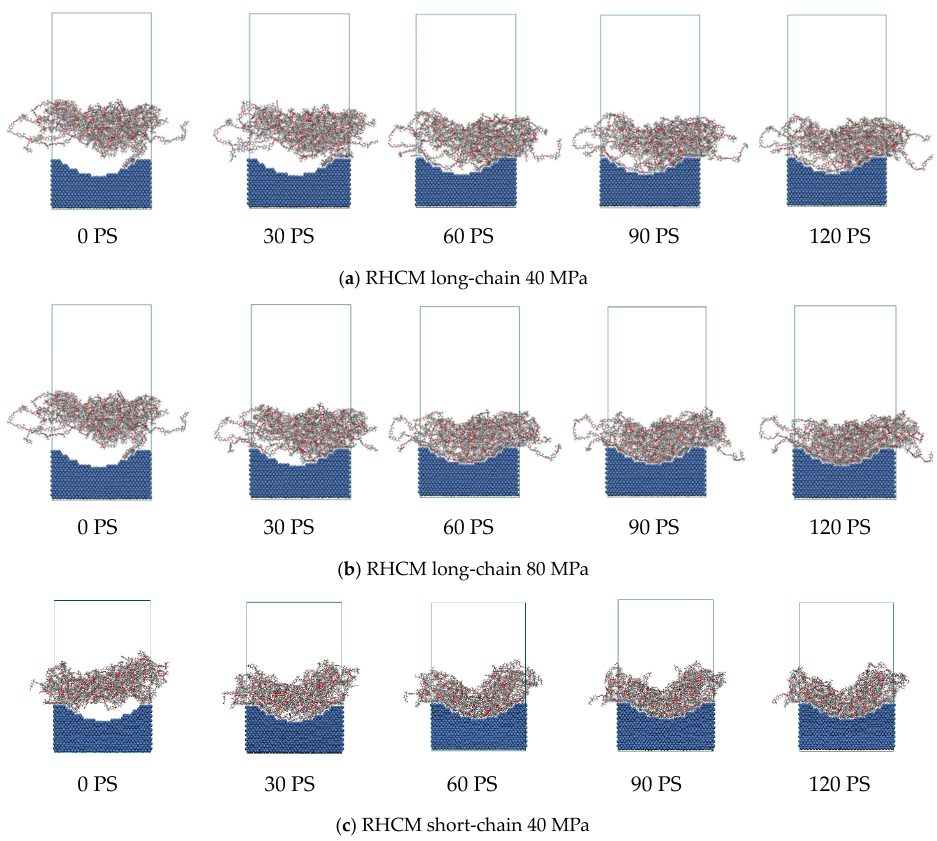
Figure 7. The filling morphological evolution of polymers in the nanostructures at different pressures during the packing stage.